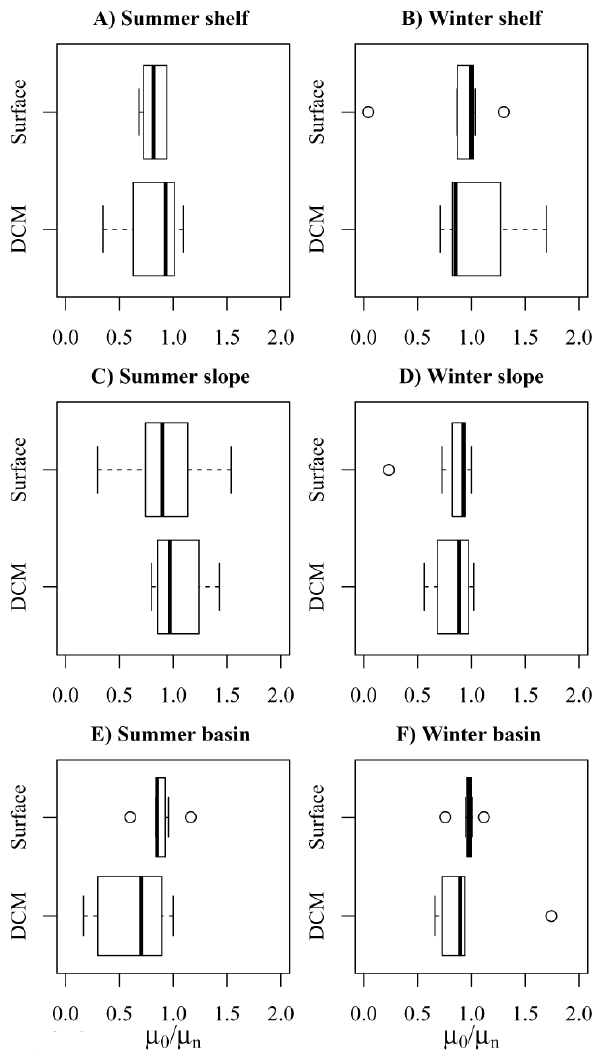
Fig. 7. Box plots of the ratio of µ 0 / µ n . µ n is the nutrient enriched phytoplankton growth rate.